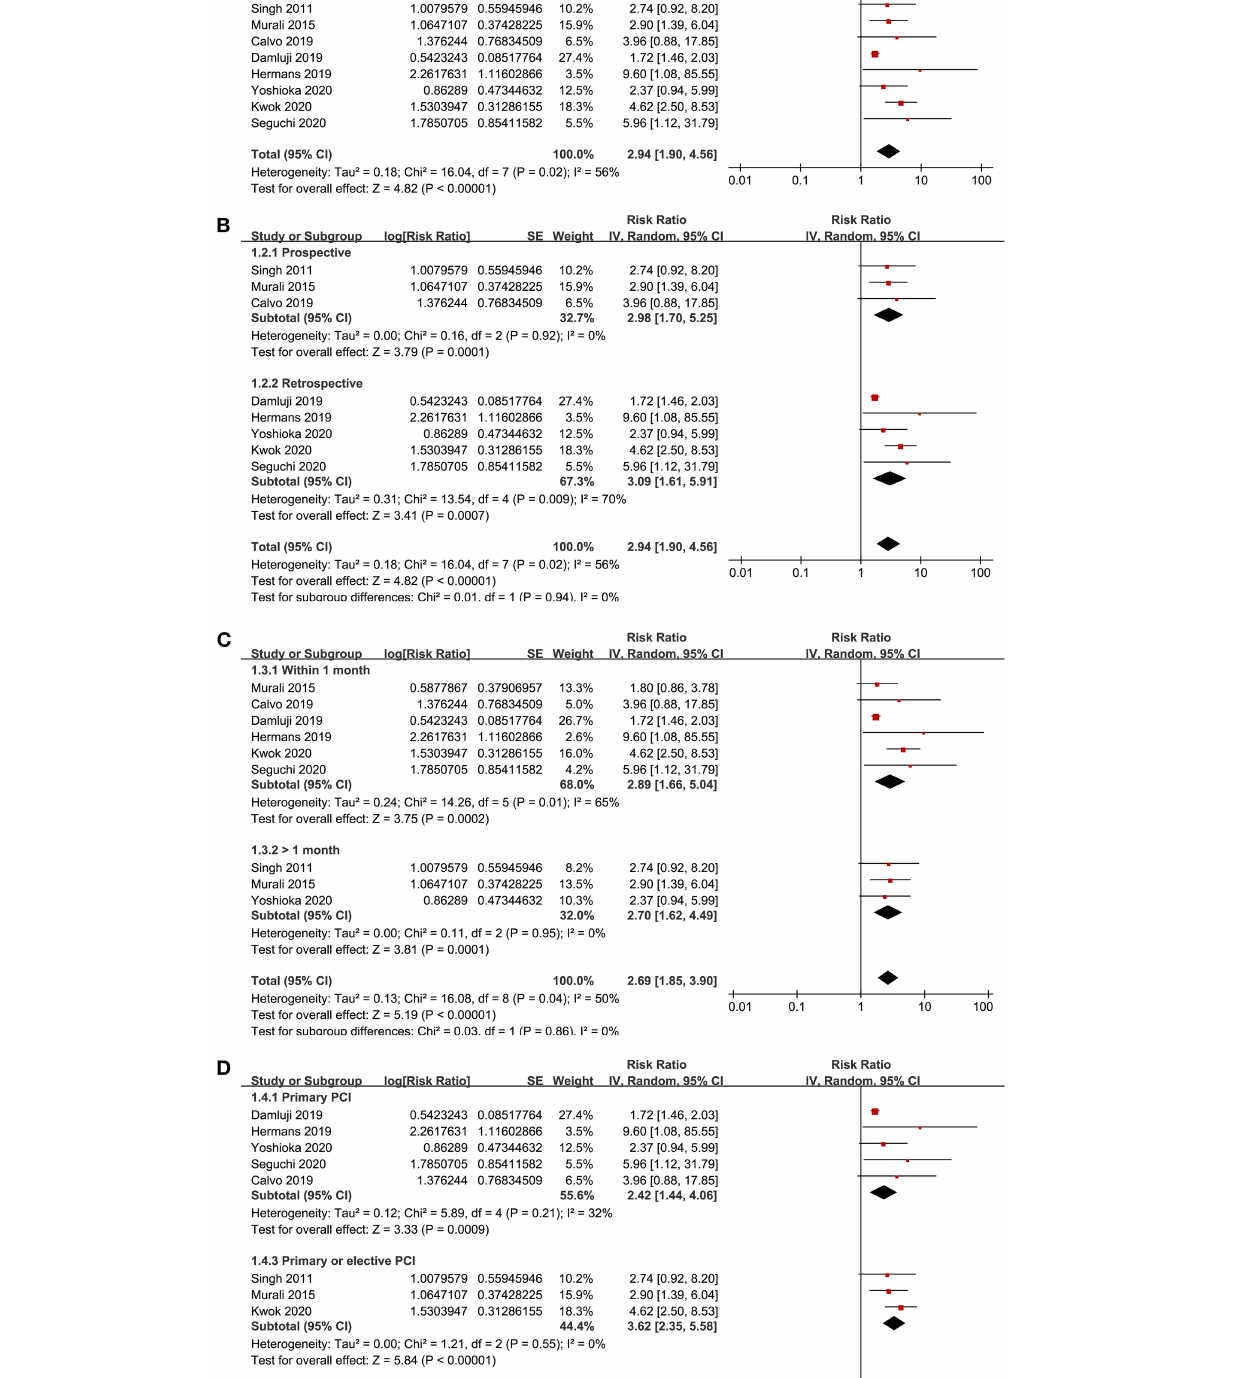
Frontiers in Medicine |